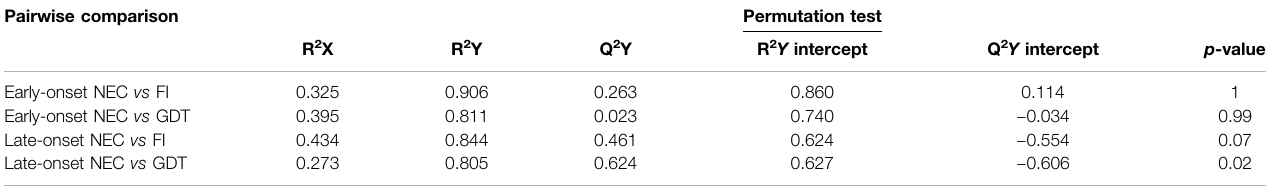
TABLE 3 | Statistical parameters for the OPLS-DA models built for the pairwise comparison between cases and controls. a